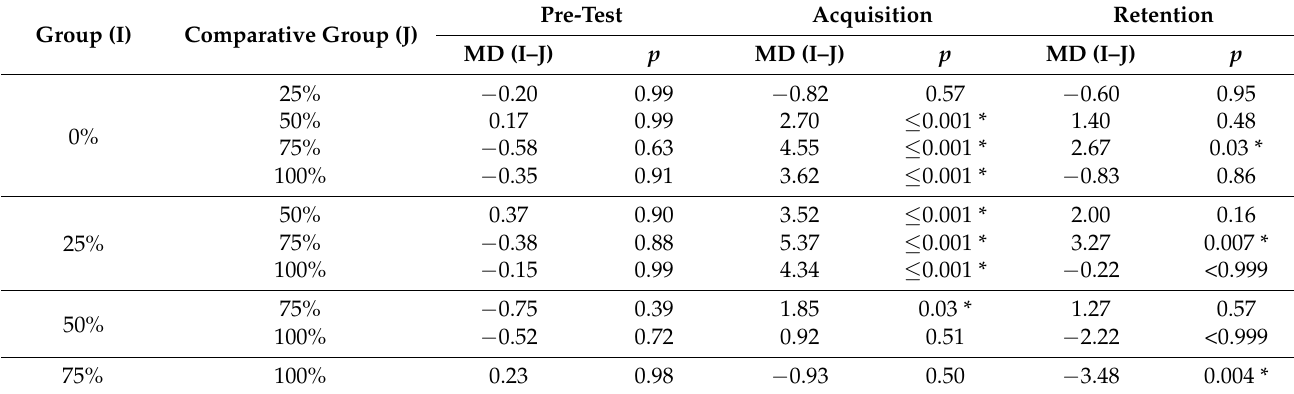
Figure 3. Performance of the groups in the tracking task tests. * Represents a statistically significant difference compared to the 75% PG group with the other groups (i.e., 0%, 25%, and 50% PG groups). Table 3. Multiple comparisons according to Tukey post-hoc